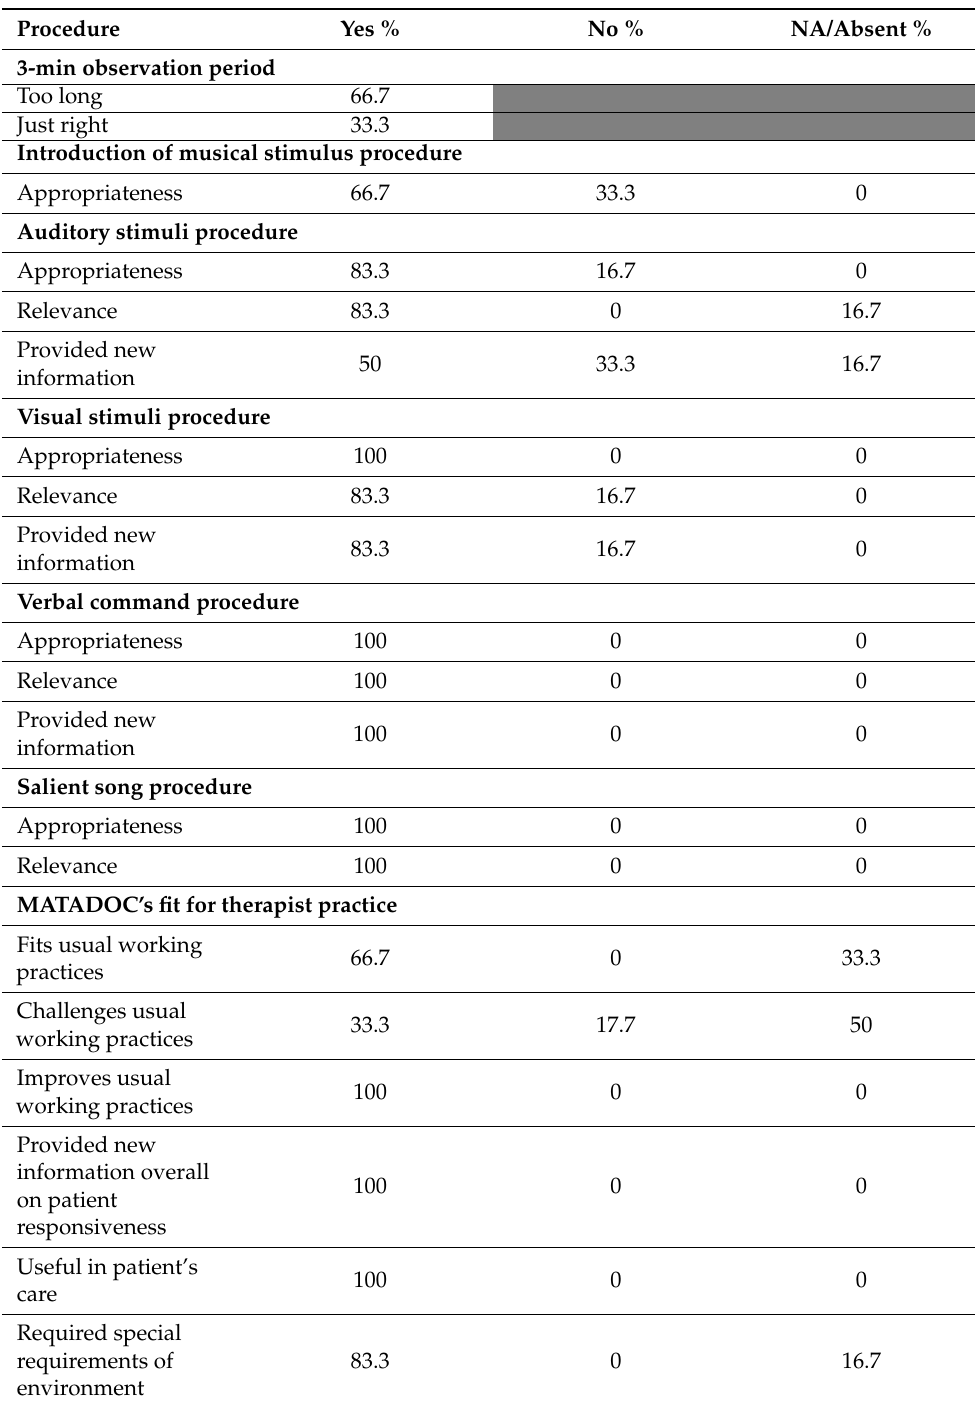
Table 4. Clinical utility